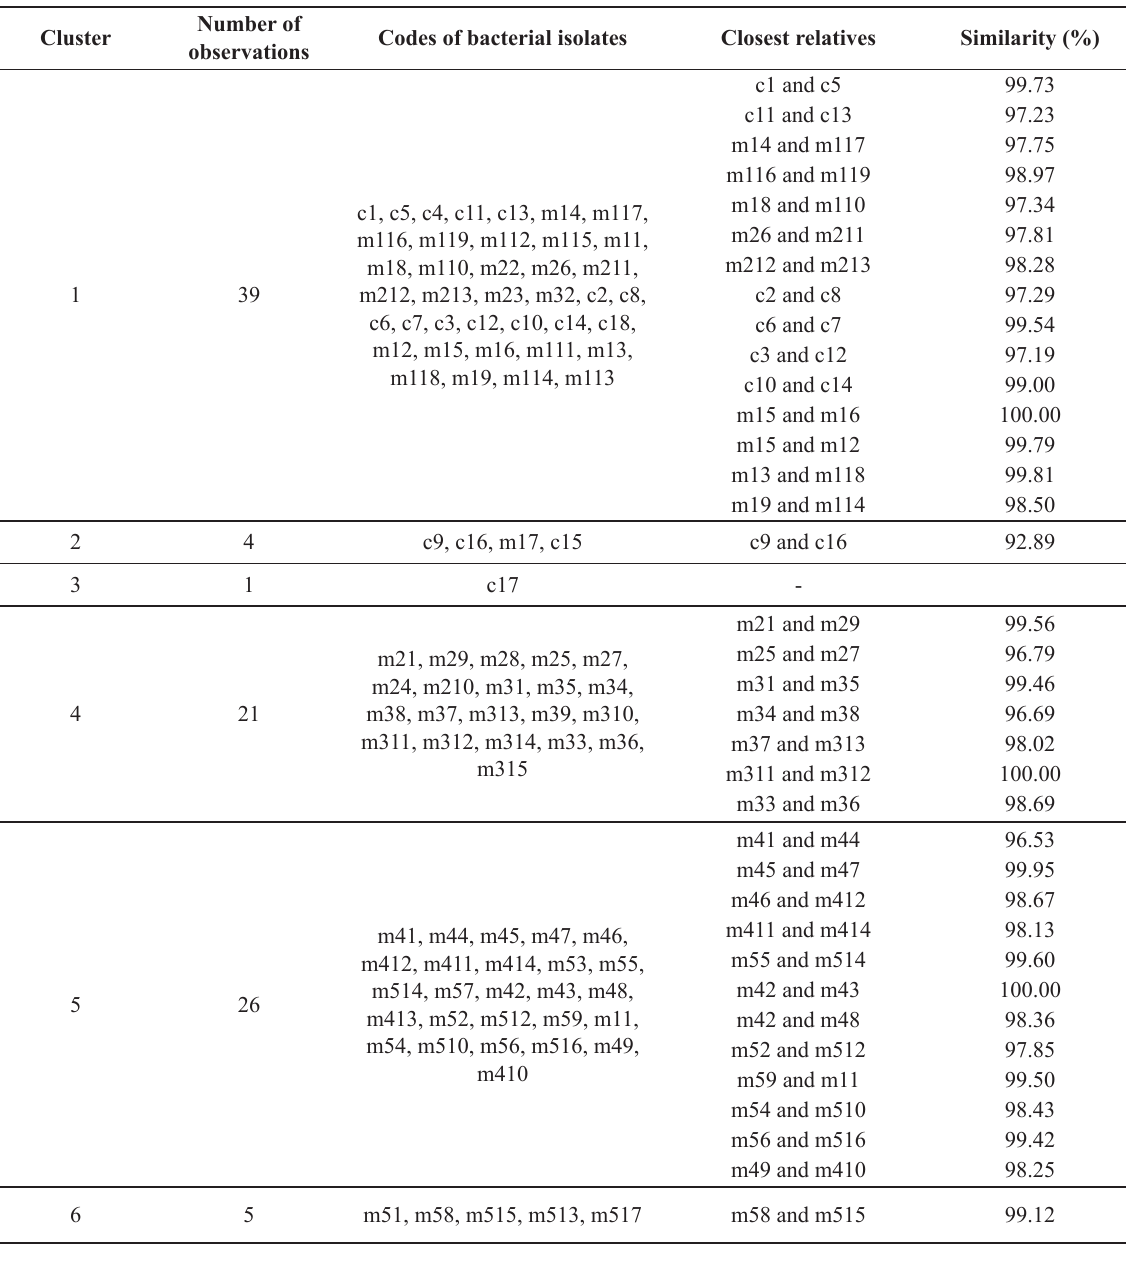
Table 1: Closest bacterial relatives of the identified clusters of the dendrogram given in figure 3 and their similarity levels. Number of Cluster